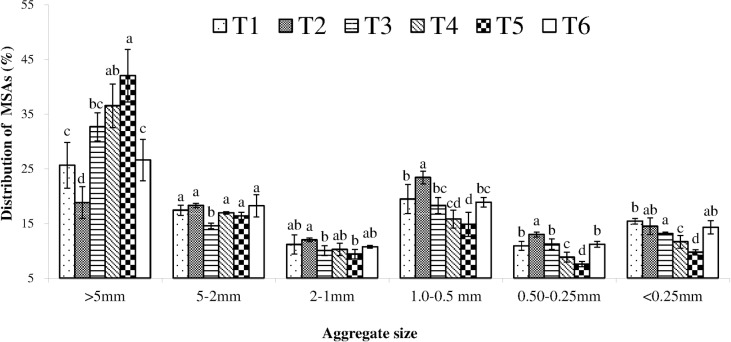
Distribution of MSAs under different treatments.Soil samples were collected at a depth of 0–20 cm after two years combined application of biogas slurry (BS) plus chemical fertilizer (CF). MSAs: mechanical—stable aggregates. T1: control (no BS or CF); T2: CF only; T3: 15% BS—TN plus 85% CF—TN, T4: 30% BS—TN plus 70% CF—TN; T5: 45% BS—TN plus 55% CF—TN; and T6: BS only. Values were mean (n = 3). vertical bars in the figures represent the standard deviation of mean (n = 3) and lower case letters indicate significant differences between treatments at the P < 0.05 level (LSD test). ANOVA source information is shown in S4 Table.